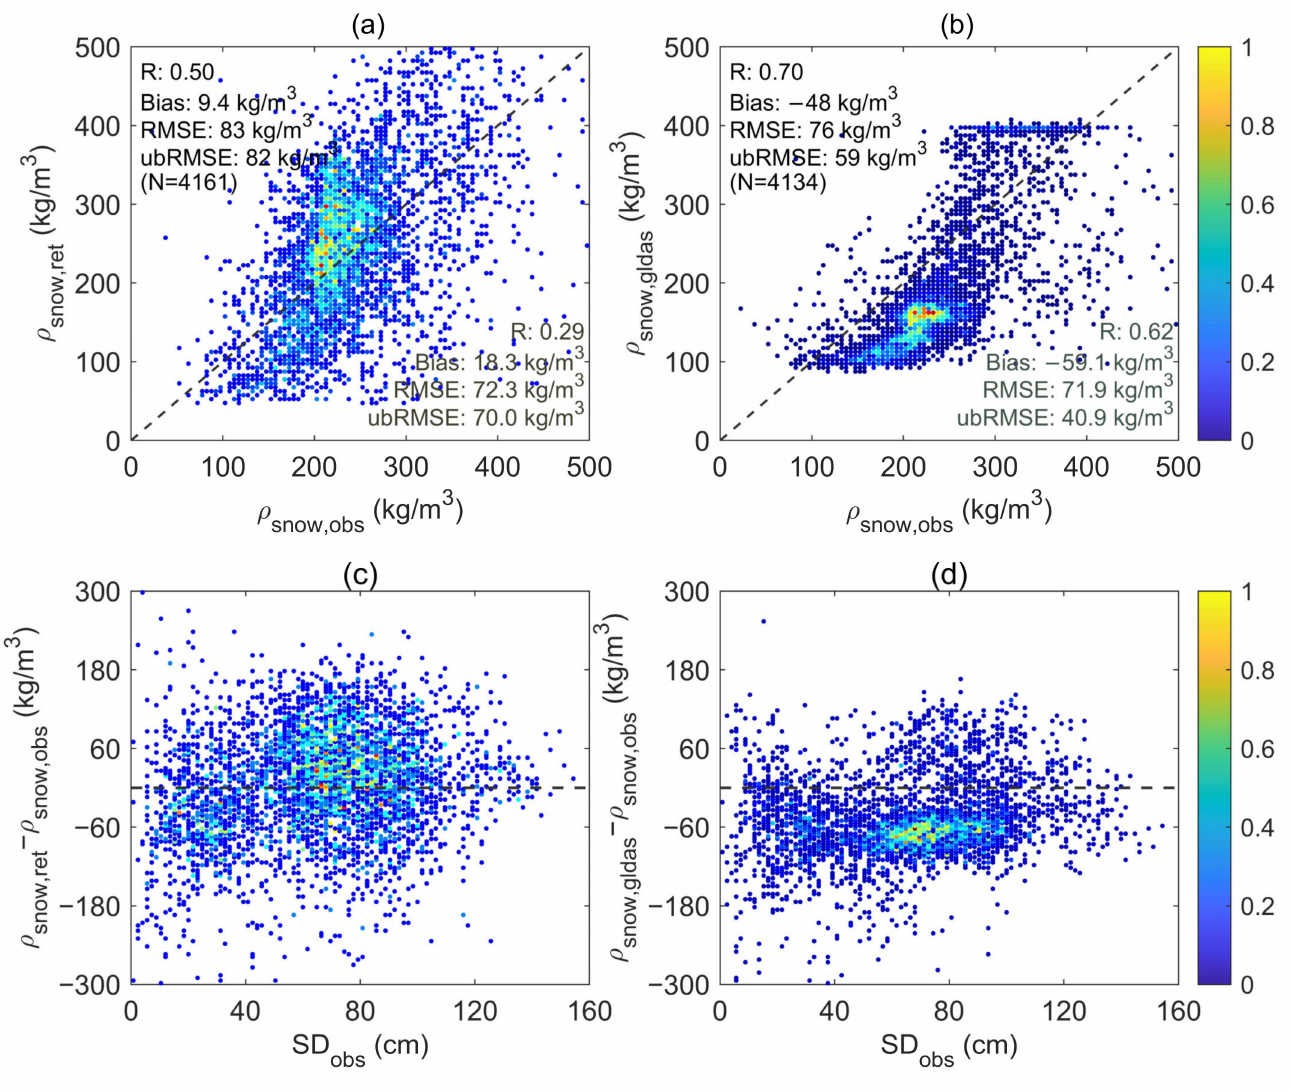
Figure 7. Scatterplots of ( a ) retrieved snow density and ( b ) reanalysis snow density from GLDAS against observed snow density, and ( c , d ) the sensitivity of biases to observed snow depth (SD obs ), from October, 2019 to June, 2020 at 43 stations located in Quebec, Canada. In ( a , b ), the validation metrics from the entire snow season (October to June) are presented in the upper left corner, whereas those from December to March are presented in the lower right